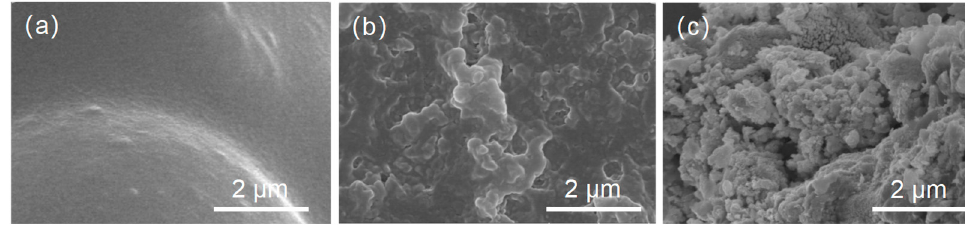
Figure 2. SEM images of ( a ) DX microcapsules, ( b ) DX-WPI microcapsules, and ( c ) DX-WPI-SP microcapsules.